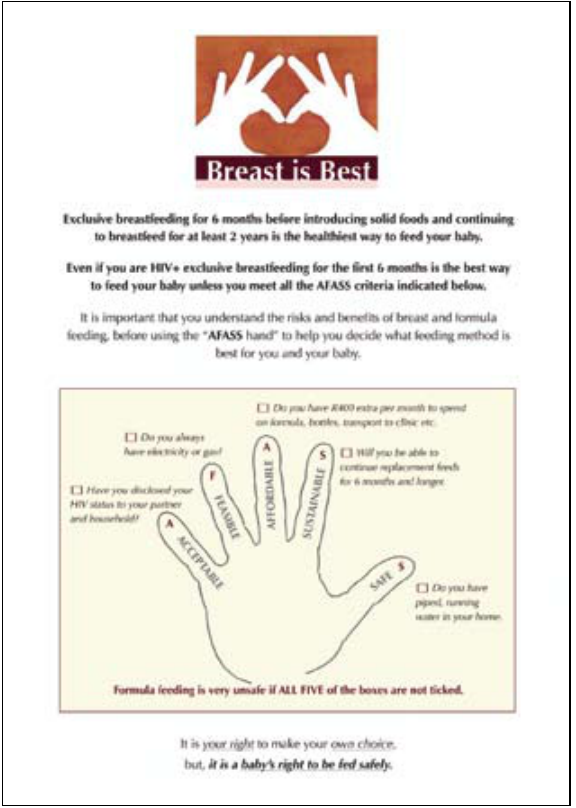
Fig. 2. A 5-finger method of assessing AFASS criteria developed by Anna Coutsoudis and colleagues (Department of Paediatrics and Child Health, UKZN) and Max Kroon, Mowbray Maternity Hospital, Western Cape. Note that this 5-finger approach is evolving, and is being amended to reduce the size of the ‘Breast is Best’ caption and text. Readers should contact Coutsoudis and Kroon for updated versions.